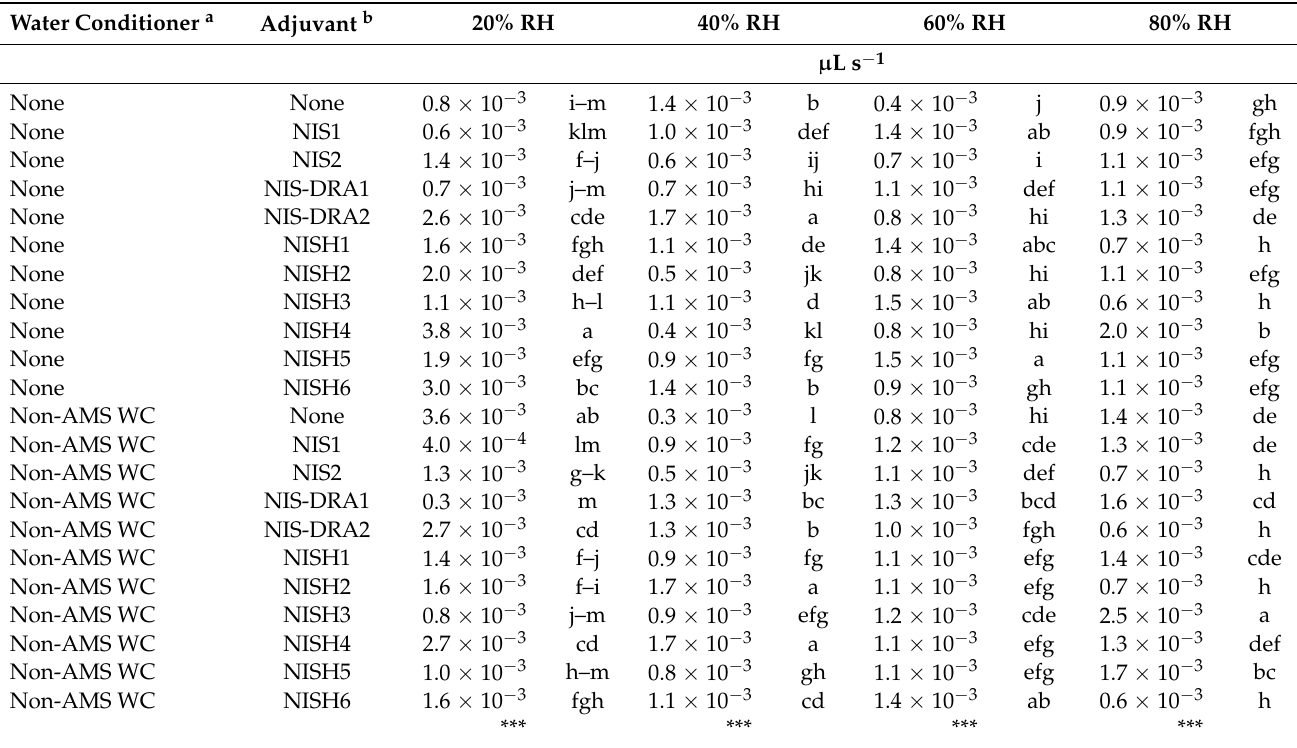
Table 6. Evaporation rate for dicamba plus glyphosate solutions at 559 and 1541 g ae ha − 1 , respectively, with and without non-AMS water conditioner alone and tank mixed with 10 adjuvants at 25 ◦ C.